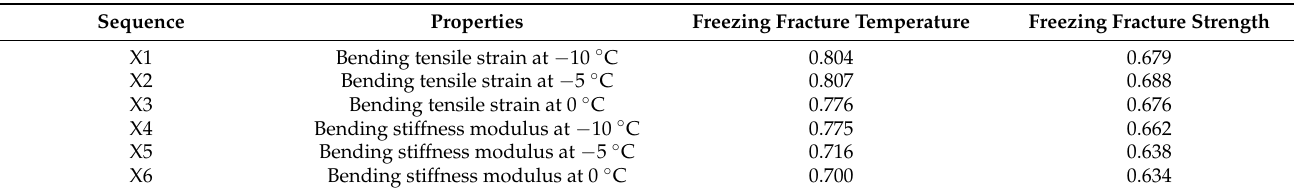
Table 11. SBS/CRM-modified SMA performance index at low